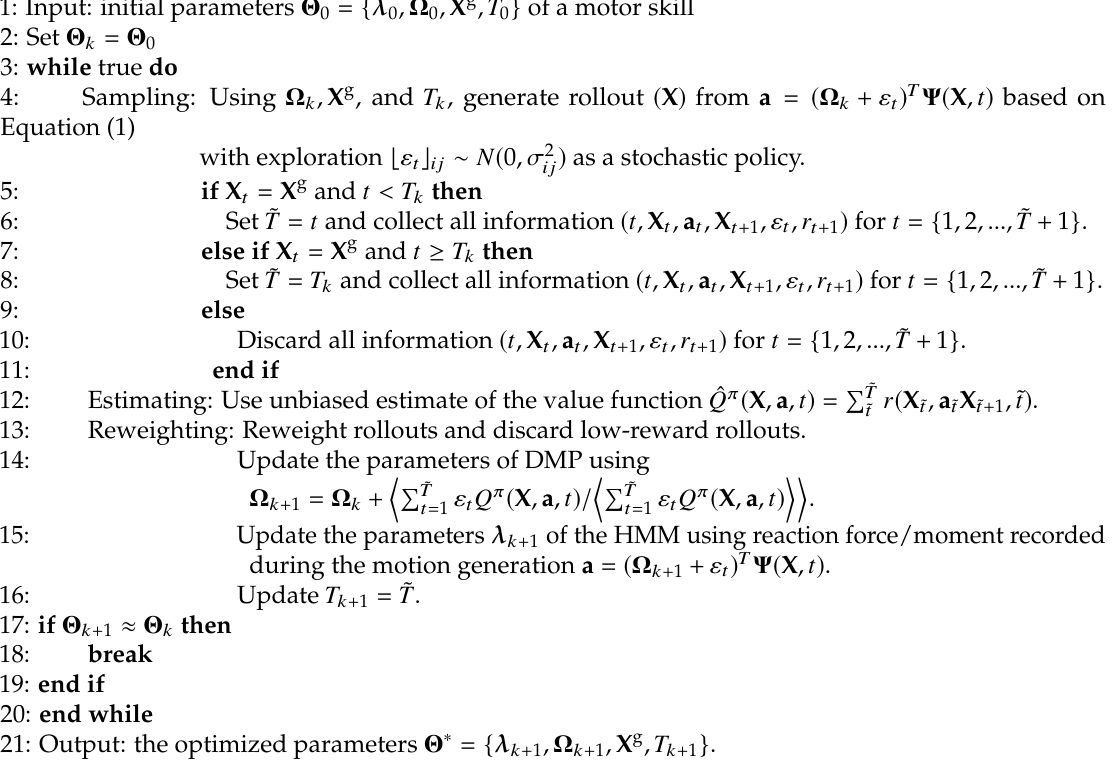
Algorithm 2 iPoWER algorithm for improving the parameters of motor skills considering execution time step and path